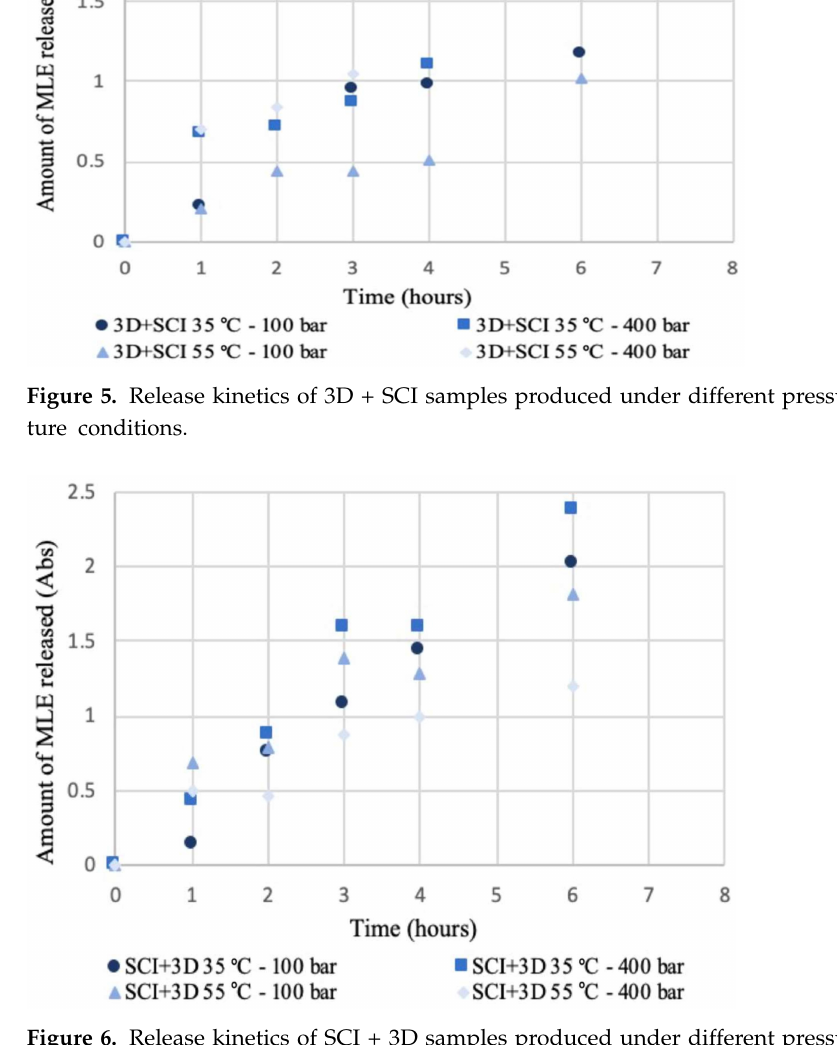
Figure 6. Release kinetics of SCI + 3D samples produced under different pressure and tempera- ture